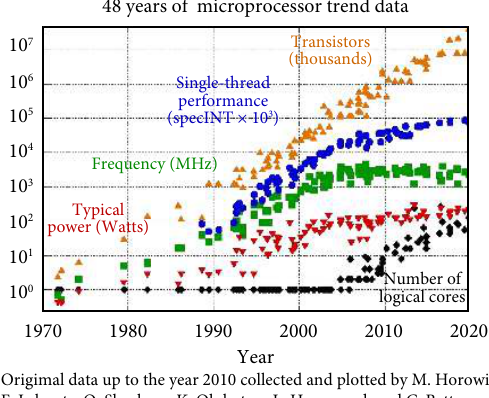
Origimal data up to the year 2010 collected and plotted by M. Horowitz, F. Labonte, O. Shacham, K. Olukotun, L. Hammond, and C. Batten New pbt and data collected for 2010-2019 by K. Rupp Fig. 2 Computer processor trending over half a century. Reprinted with permission from ref. [2] © Karl Rupp 2020.